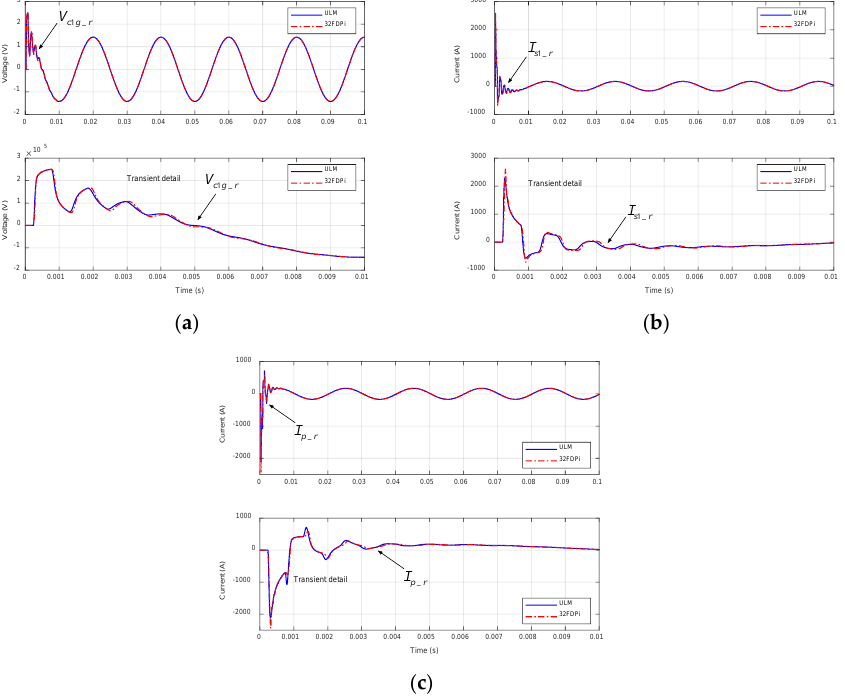
Figure 6. Time response comparison for Case Study #1. ( a ) V c1g_r . ( b ) I s1_r . ( c ) I p_r .